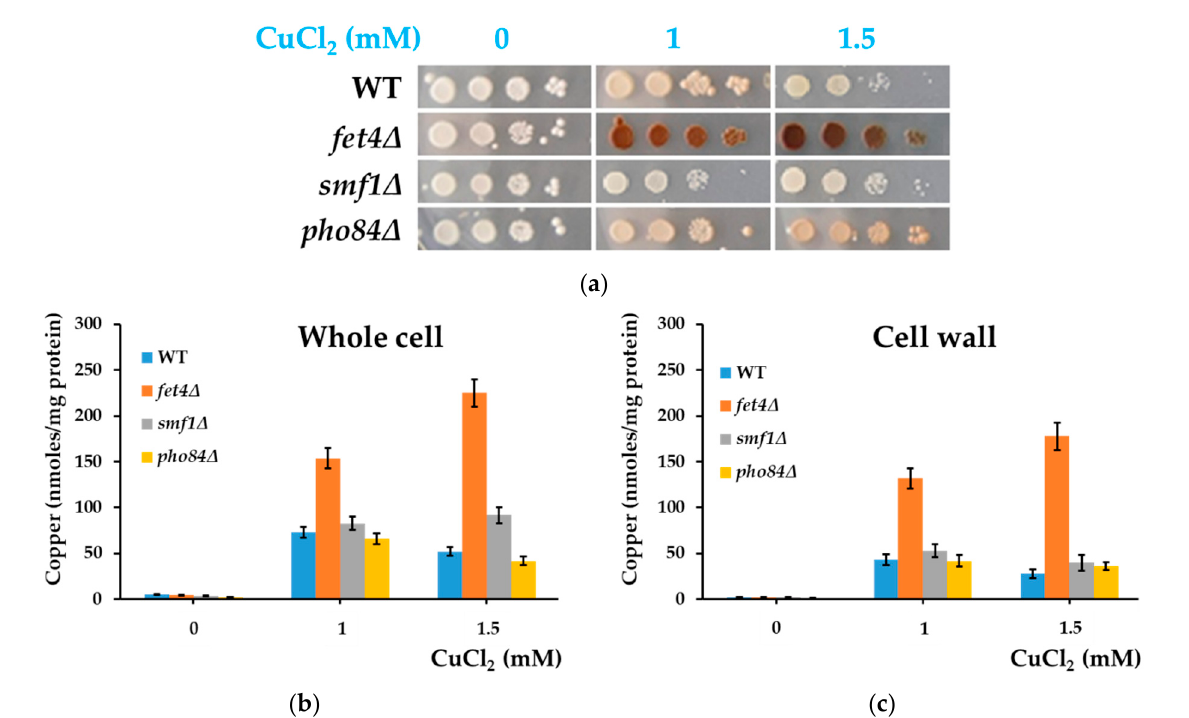
Figure 6. Coloration and accumulation of copper by Saccharomyces cerevisiae strains with defects in low-affinity transport of copper across the plasma membrane. ( a ) Cell suspensions of strain BY4741 (WT) and of isogenic strains fet4 Δ , smf1 Δ , and pho84 Δ were spotted in serial dilution onto MM/Glc (Glucose) media with various concentrations of CuCl 2 . Plates shown were photographed after 6 days of incubation at 28 °C. ( b ) Copper accumulation by cells grown statically on MM/Glc agar media. Cell suspensions were spotted on agar plates (approximately 10 6 cells/5 µL spot) and incubated at 28 °C. Cell patches were harvested after 6 days of incubation and processed for copper assay, as described in Section 2. ( c ) Copper associated with cell walls. The cells used to determine whole-cell copper, cell wall copper, and total cell protein used for normalization belong to the same batch. Values are mean ± SEM of triplicate determination done on three biolog- ical repeats.